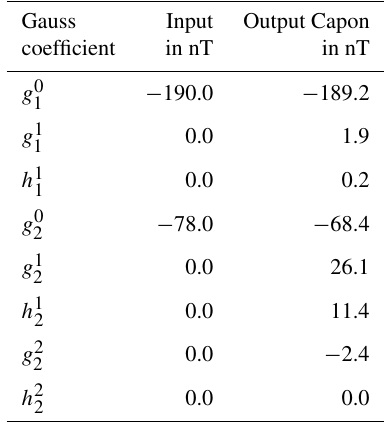
Table 1. Implemented and reconstructed Gauss coefficients for the internal dipole and quadrupole